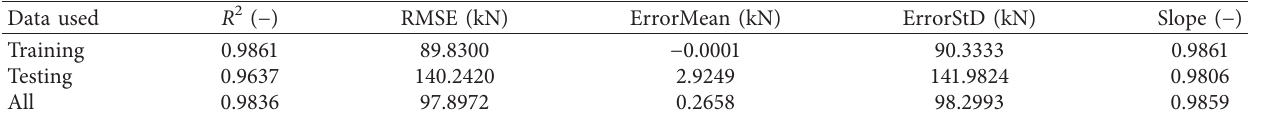
Figure 7: Ultimate load as a function of sample index: (a) using training data, (b) using testing data, and (c) using all data, for one case in 11- cross folds. Table 4: Average prediction capability of ANFIS model over 11-cross folds.